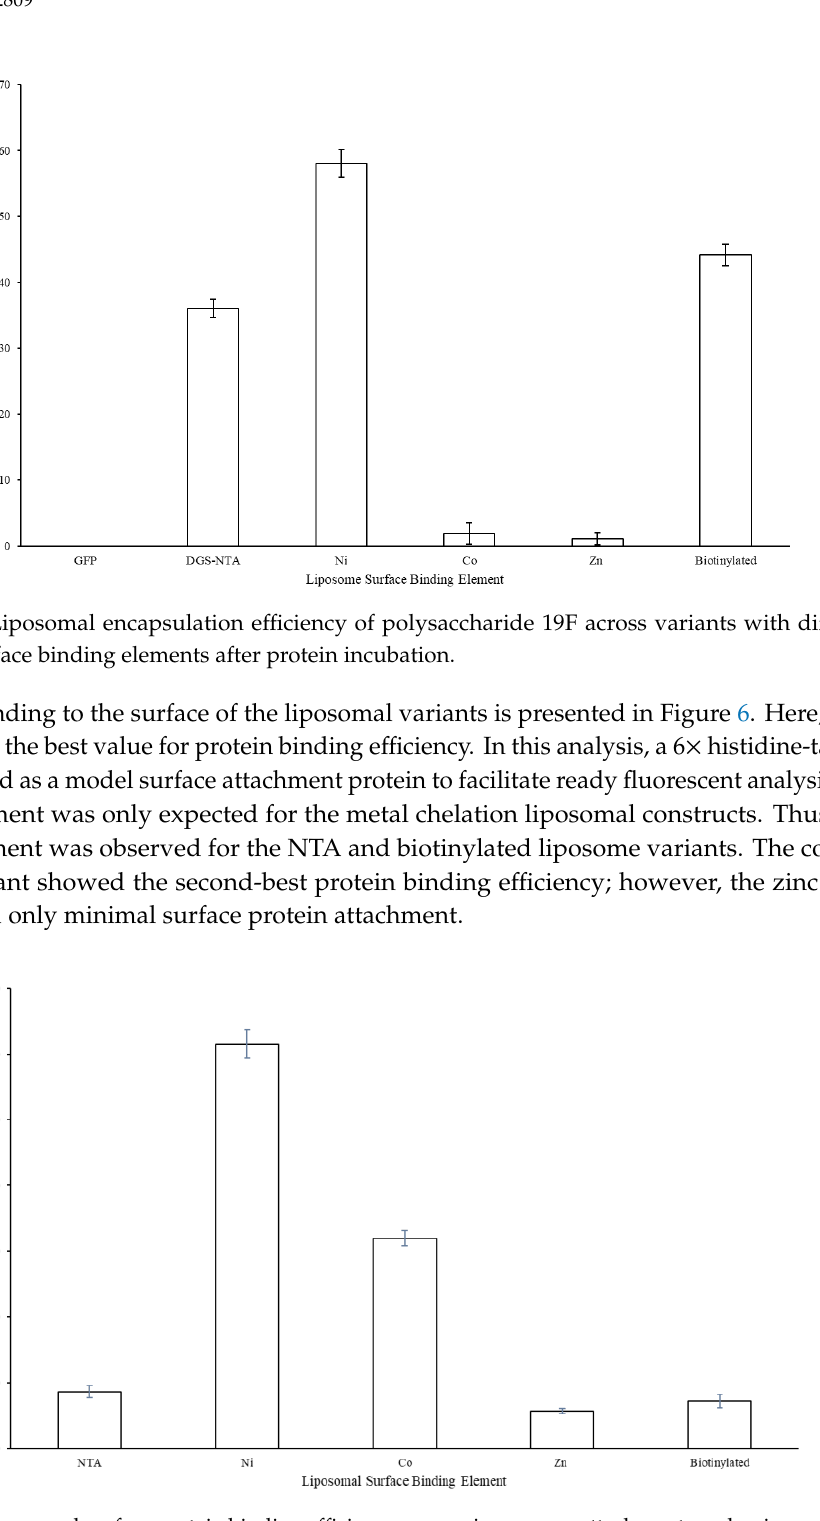
Figure 6. Liposomal surface protein binding efficiency comparison across attachment mechanism variants.